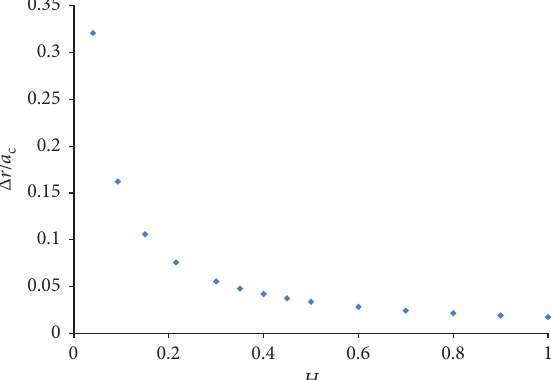
Figure 9: Variation in values of ( K specimens ( A ∗ n is the dimensionless coefficients of the terms in Williams’s series expansion).